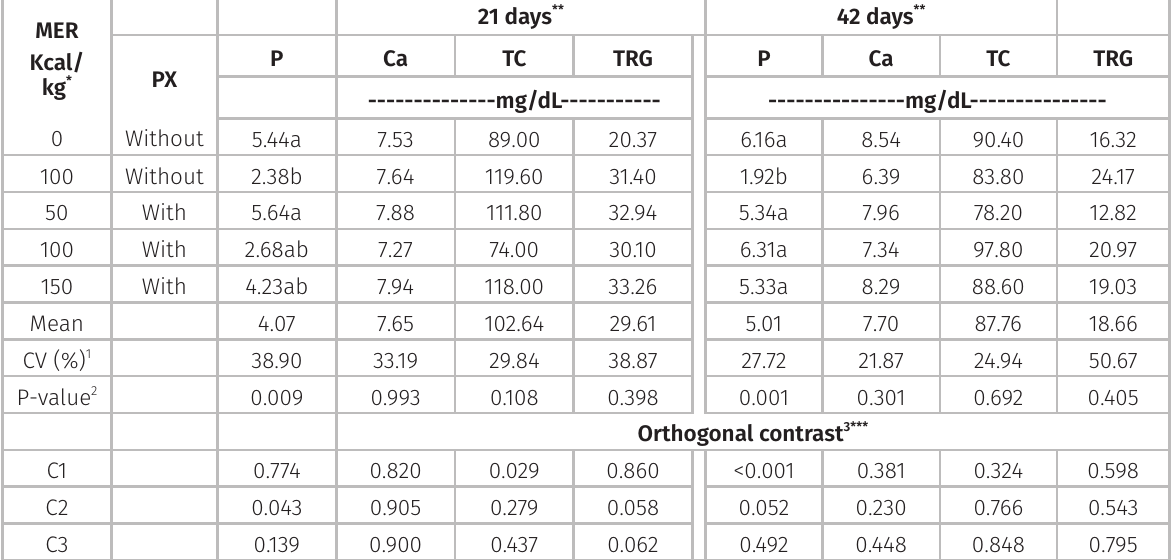
Table VII. Serum biochemical profile of broilers fed diets with reductions in metabolizable energy (MER), P, Ca and Na and supplemented with phytase and xylanase